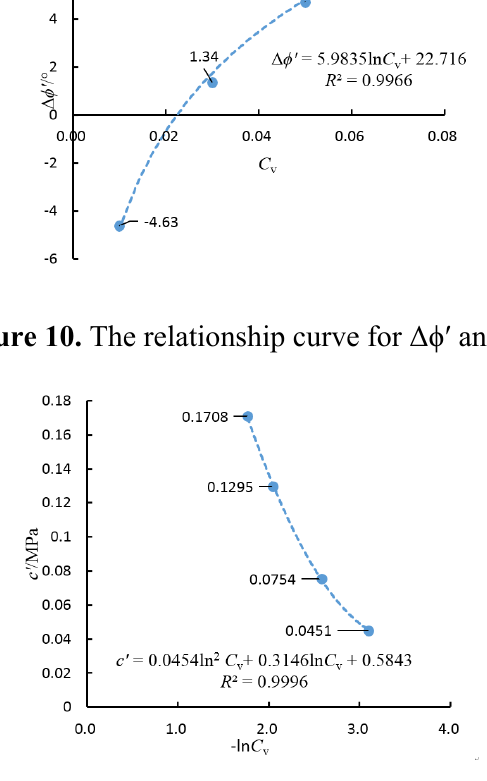
Figure 11. The relationship curve for c ′ and − ln C v